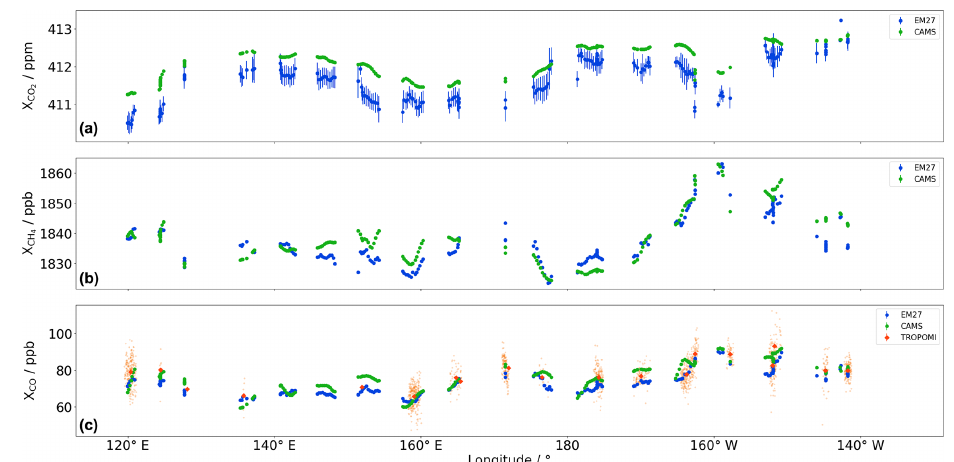
Figure 5. XCO 2 (a) , XCH 4 (b) , and XCO (c) measured by the shipborne EM27/SUN (blue) above the Pacific alongside coincident CAMS atmospheric composition analysis data (green) and coincident XCO satellite observations by TROPOMI (orange). EM27/SUN measurements and CAMS data are hourly averages, while TROPOMI observations are averaged per overflight. Single TROPOMI measurements are marked small in the background.